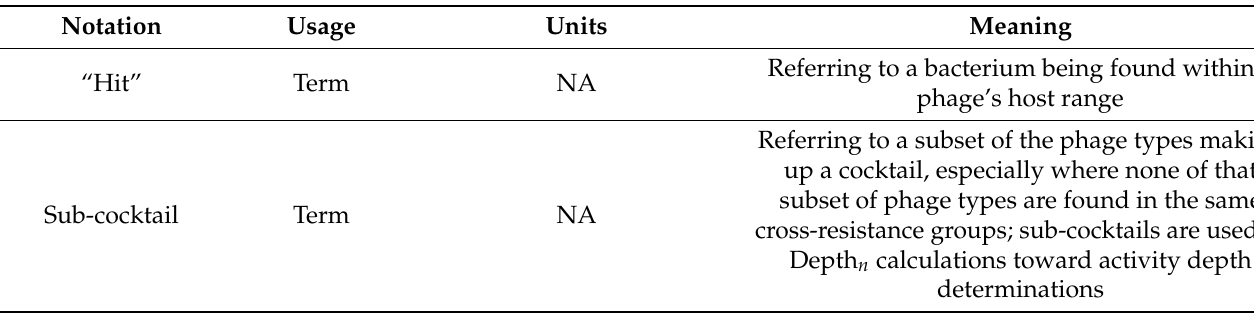
Figure 2. Determination of phage cocktail breadth of activity in light of depth. Panel I shows a set of phage host-range data (in columns), with 0s indicating those bacteria (in rows) that are found outside of a phage’s host range and 1s indicating those bacteria that are found within a phage’s host range. Panel II shows the breadth of activity of combinations of 6, 5, 4, 3, or 2 phages—as assembled from phage isolates indicated in Panel I —that have been identified as cocktails having the broadest spectra (“Percent bacteria hit”). This is in terms of each bacterium being impacted by at least one phage and which thereby represent what we describe as ‘Breadth 1 ’. These Breadth 1 determinations are calculated using Equation (1). Panel III is equivalent to Panel II except bacteria must be ‘hit’ by at least two phages to be counted, rather than by at least one phage (the latter is calculated instead for Panel II ). These ‘Breadth 2 ’ determinations are calculated using Equation (2). Table 2. Summary of terms and notations